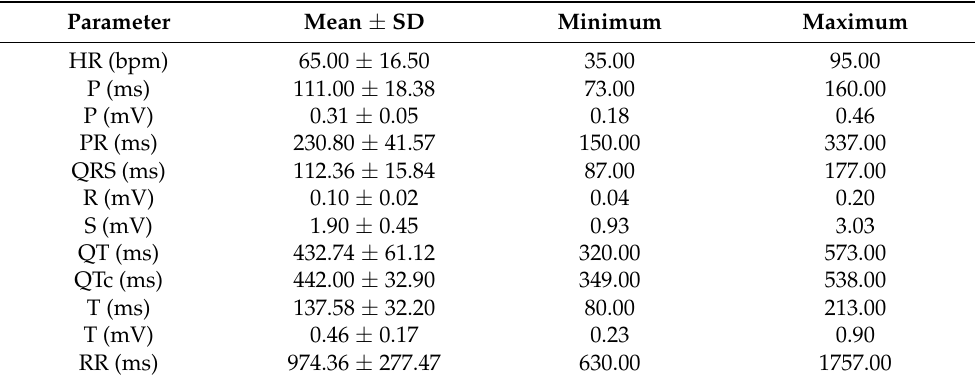
Table 3. Electrocardiographic parameters in Pega breed donkeys (mean, standard deviation, mini- mum, maximum), males ( n = 20) and females ( n = 30).